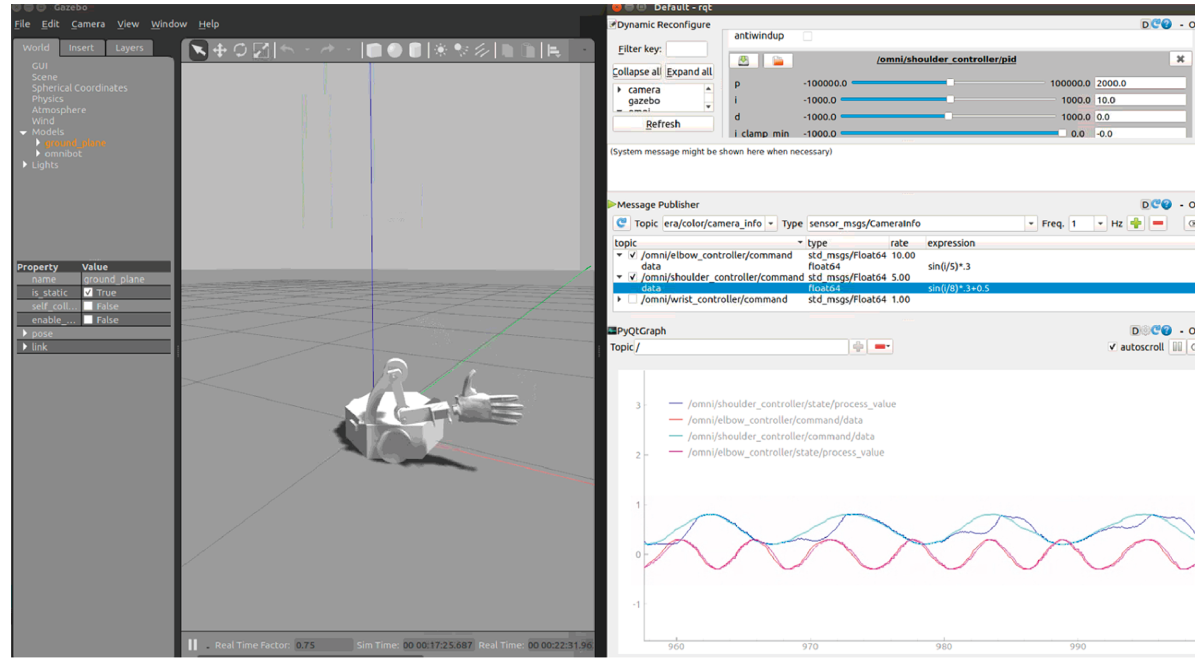
Figure 17: Tuning environment setup.